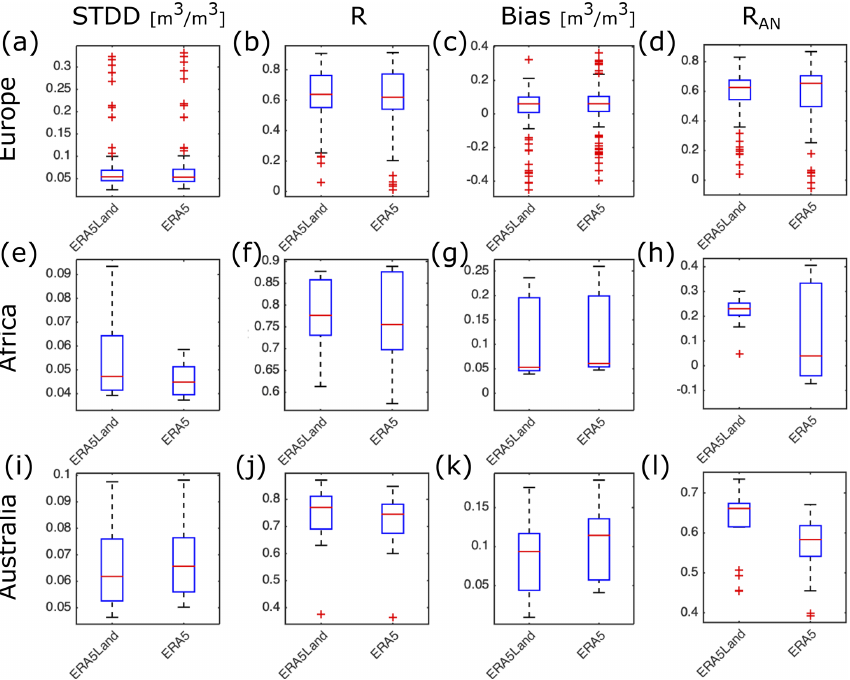
Figure 6. Box plots showing the evaluation of ERA5-Land and ERA5 top layer soil moisture against in situ measurements at 5cm for sites in Europe (a–d) , Africa (e–h) , and Australia (i–l) . Panels (a) , (e) , and (i) show the standard deviation of the difference (STDD), (b) , (f) , and (j) the Pearson correlation coefficient ( R ), (c) , (g) , and (k) the bias, and (d) , (h) , and (l) the Pearson correlation of the anomaly time series ( R AN ). On each box, the central mark indicates the median, and the bottom and top edges of the box indicate the 25th ( q 25 ) and 75th ( q 75 ) percentiles, respectively. The whiskers extend to the most extreme data points not considered